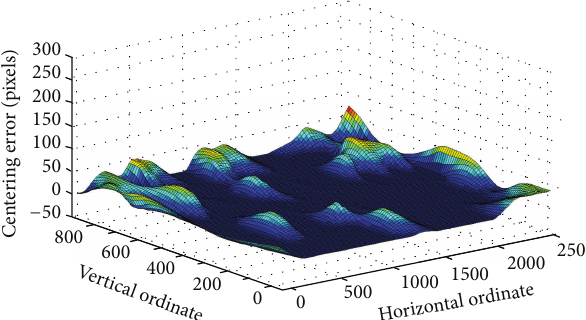
Figure 8: Mean error between requested and the ground truth